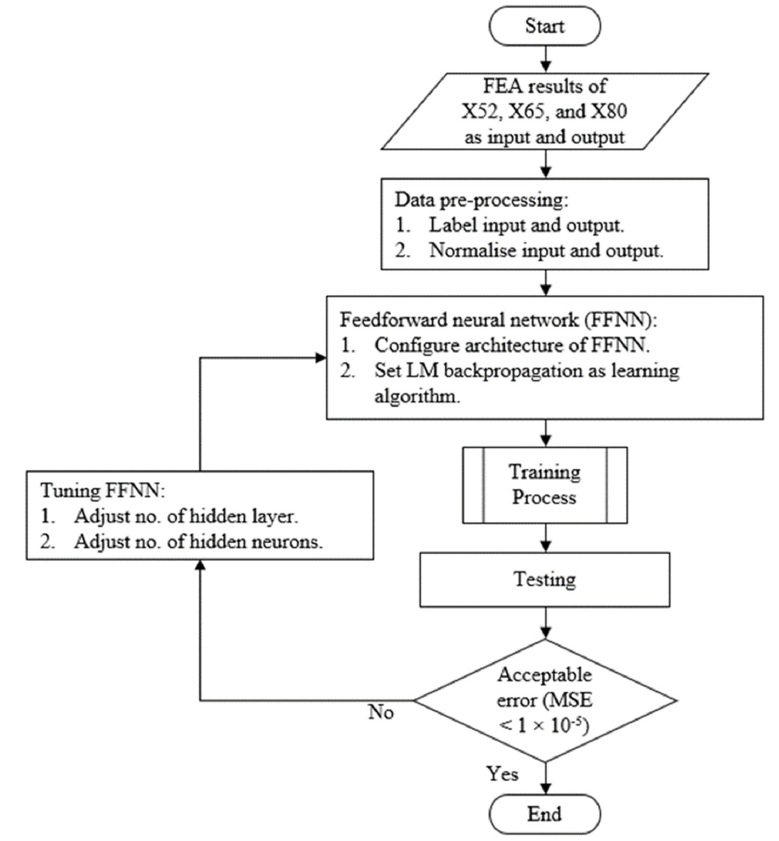
Figure 5. ANN framework for this study.